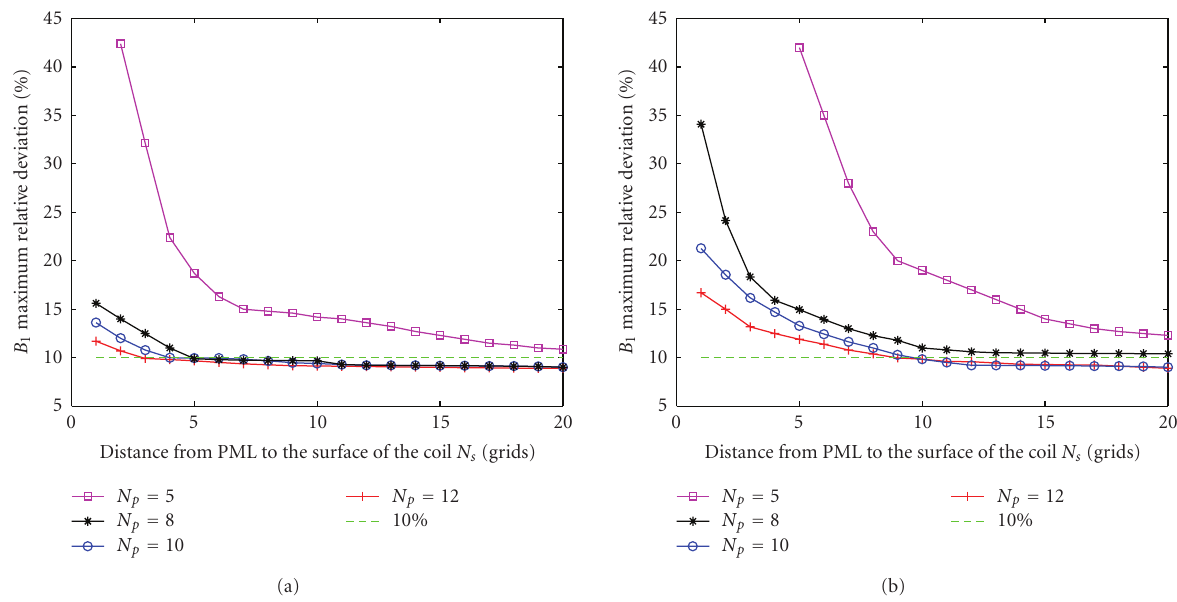
Figure 5: Maximum deviations of the calculated B 1 -field within a circular region positioned in axial plane at the center of the coil. This region has a diameter that is 80% of the coil’s diameter. The results are presented at 127.72 MHz, the (a) Larmor frequency of 1 H at 3T after iterations of 40 cycles and (b) after iterations of 120